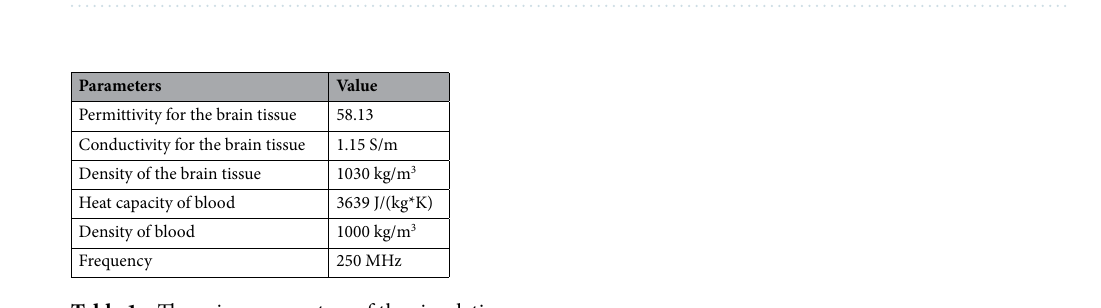
Table 1. The using parameters of the